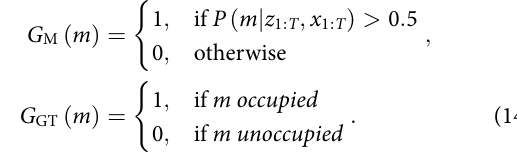
such that they meet the size and resolution of the GT